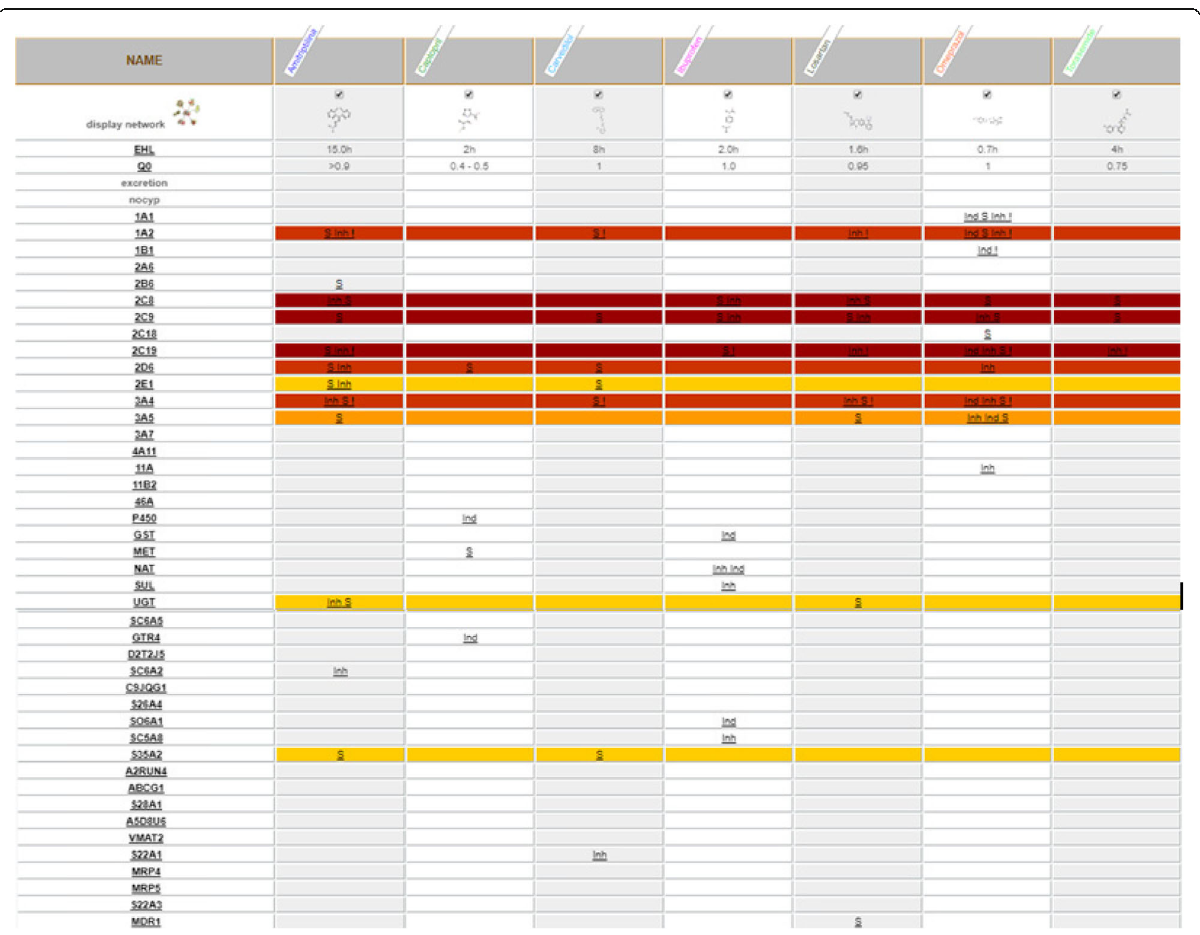
Fig. 9 Drug-drug interaction involved in a polytherapy for hypertension, prophylactic therapy for chronic migraine and episodes of acute attacks. From left to right, in the first column there is the list of drug metabolizing enzymes, one for each row, each following column represent a drug the relationship between a drug and an enzyme/transporter is indicated by the symbol ‘ S ’ for substrate, ‘ Inh ’ for inhibitor and ‘ Ind ’ for inducer. The colours of different rows indicate the increase in metabolic pressure passing by the various colours ranging from yellow to orange, to red, to dark red. Related page at the website